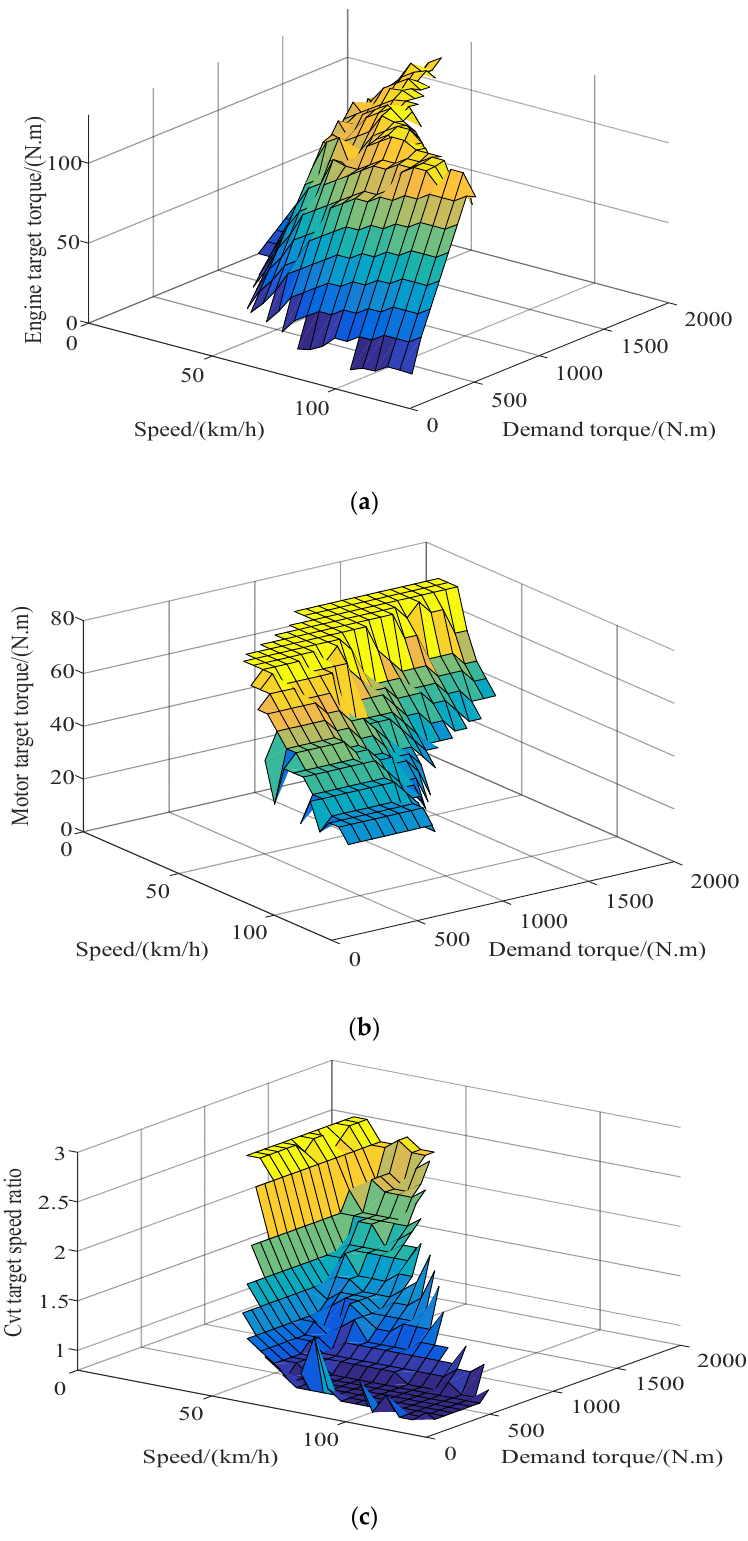
Figure 11. Optimization results in oil–electro hybrid drive mode: ( a ) engine target torque; ( b ) motor target torque; ( c ) CVT of target speed ratio.